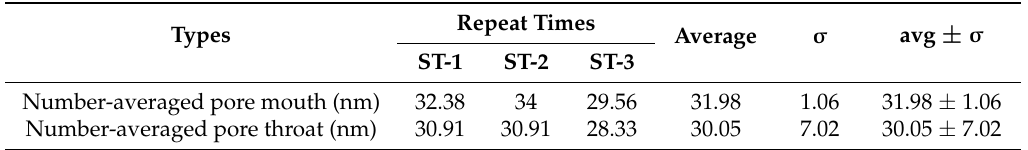
Figure 9. Characterization of single tubular ZrO 2 / γ -Al 2 O 3 / α -Al 2 O 3 membranes with 3 replicate samples: ( a ) Averaged pore mouth size distribution in comparison with that for Sample 1; ( b ) Comparison of averaged pore mouth size distribution and averaged pore throat size distribution. Table 7. Summary of MLLDP results for three replicate samples of nominal 30 nm single tubular ZrO 2 / γ -Al 2 O 3 / α -Al 2 O 3 membrane.